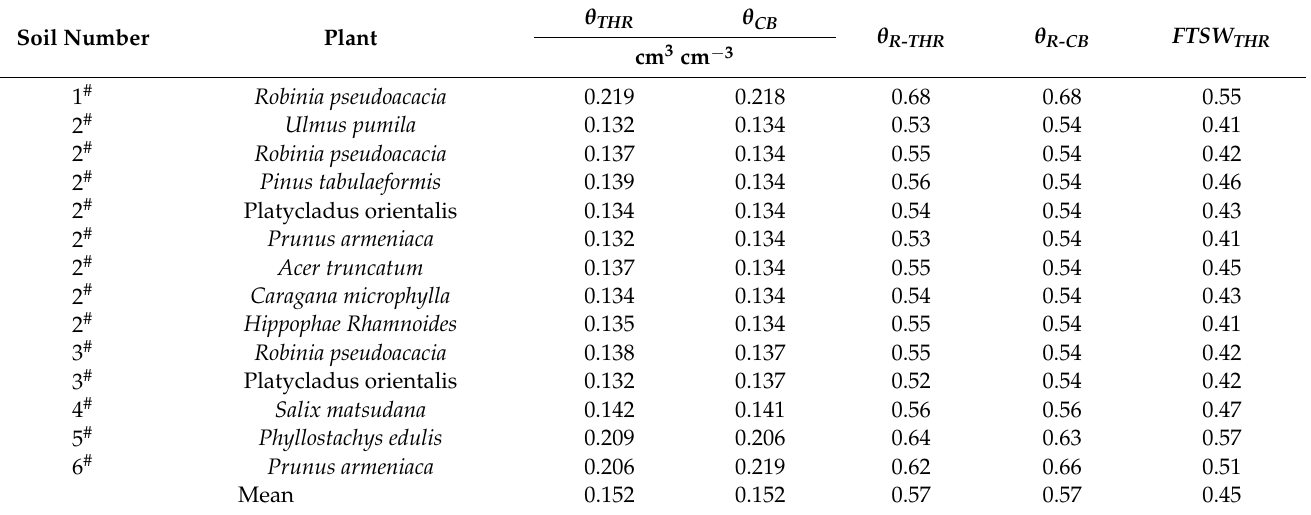
Table 2. The soil water content threshold ( θ THR ), soil water content of capillary break ( θ CB ),